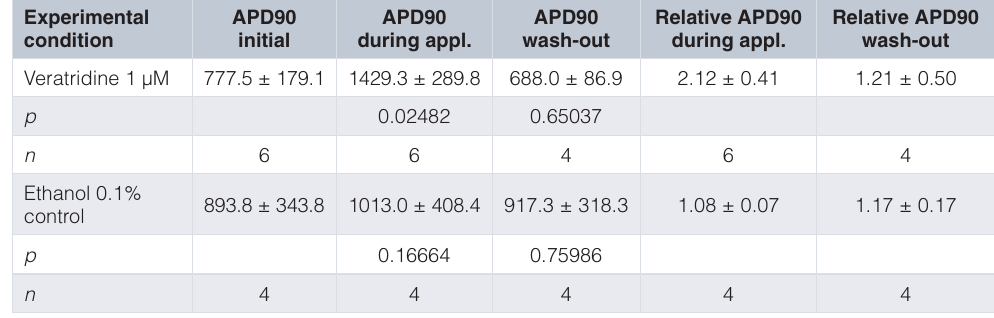
Table 2. Changes in APD90 duration (in ms, mean ± SEM) induced by veratridine in hiPSC-derived